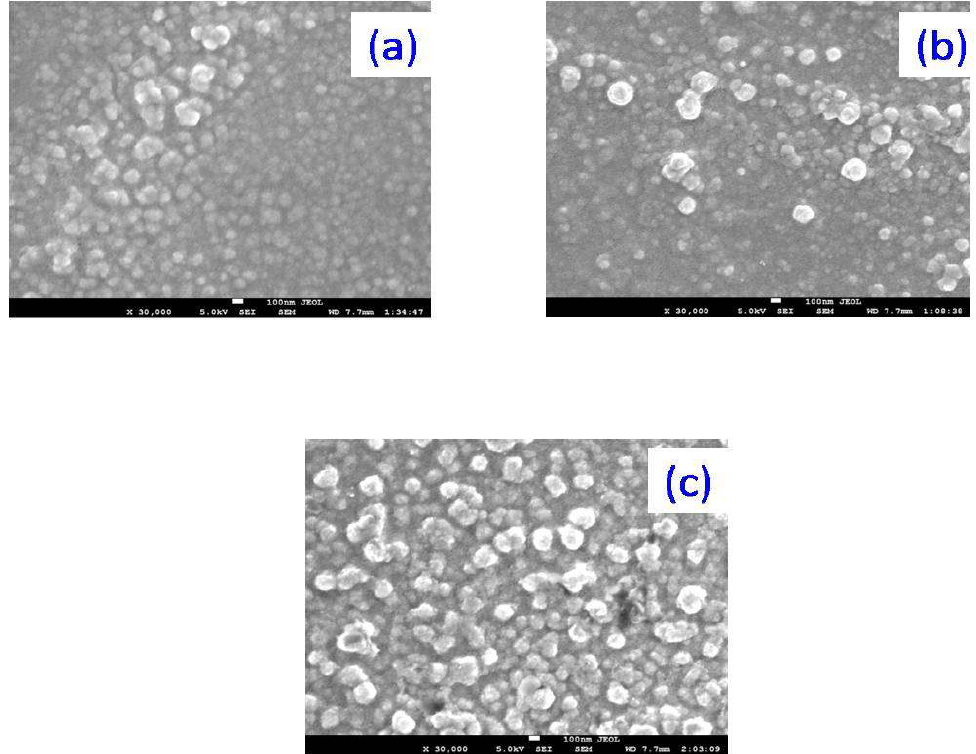
Figure 2. SEM images Evolution the NiO microstructure with Cu-doping. ( a ) Pure NiO, ( b ) 6% Cu-NiO, and ( c ) 10% Cu-NiO.